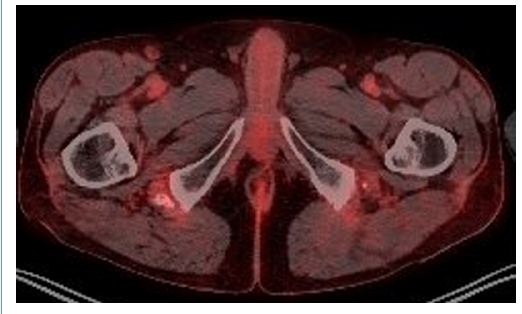
Figure 6: PET-CT of the pelvis 13 month after the rupture: axial